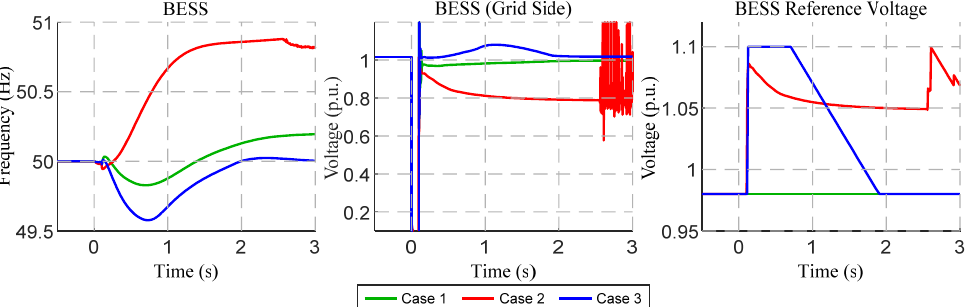
Figure 33. BESS power converter synthetic frequency, grid terminal voltage and reference and voltage reference for voltage control loop.